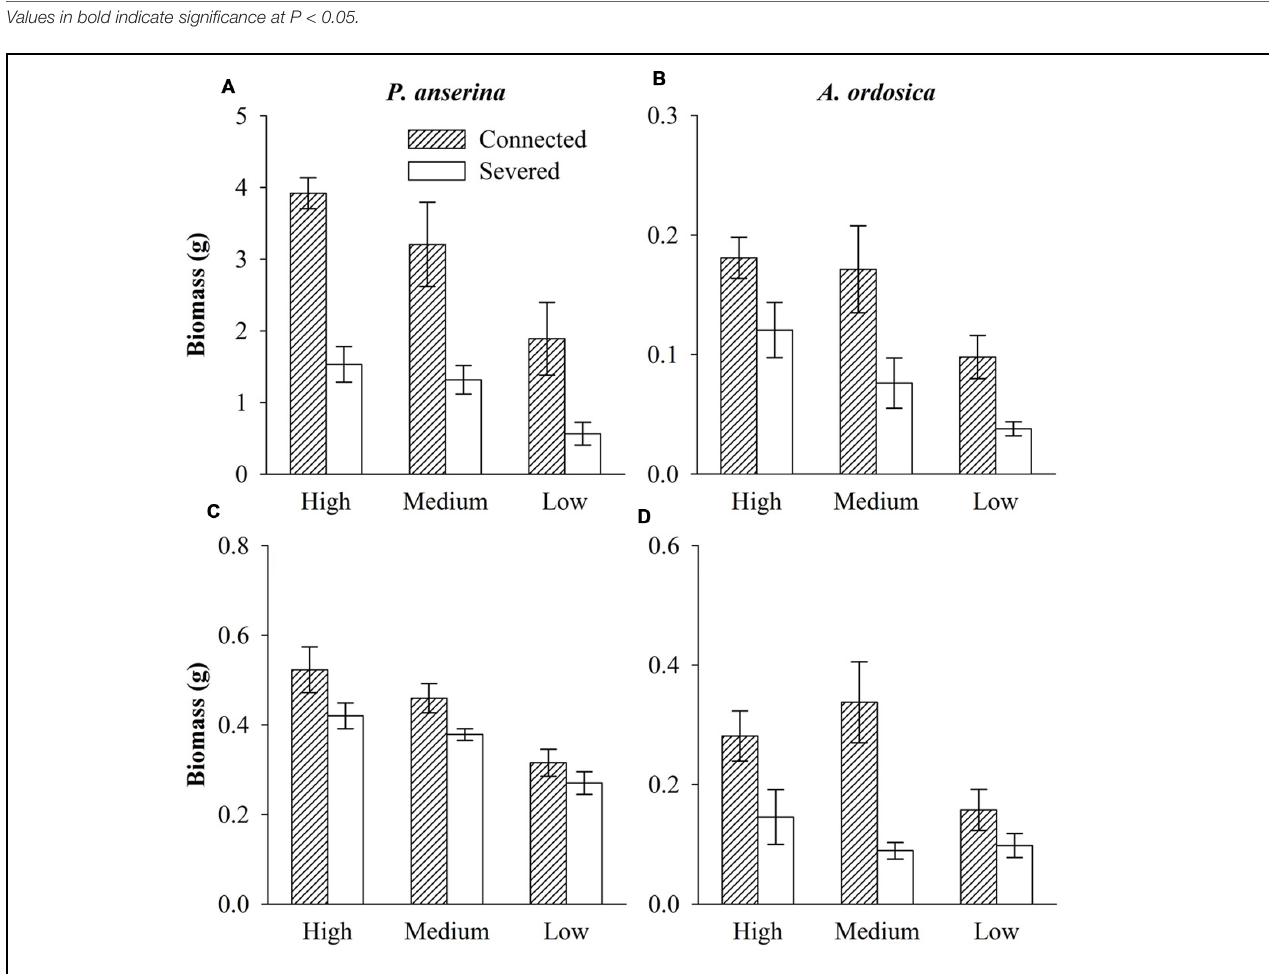
FIGURE 3 | Biomass of P. anserina (A,C) and Artemisia ordosica (B,D) in the unlabeled containers with the high, medium, and low water treatments that were connected with or severed from the P. anserina ramets grown in the high water treatment in Experiment I (A,B) and Experiment II (C,D).